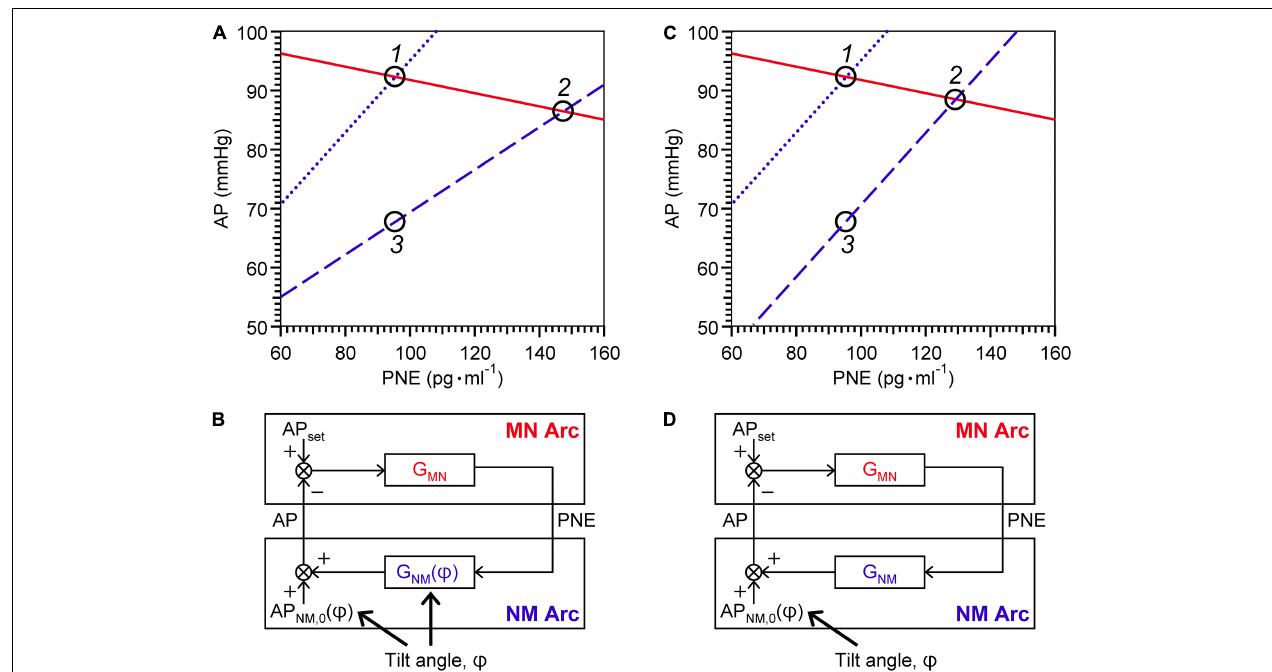
FIGURE 3 | Graphical representation of physiological meanings of gain factors of MN and NM arcs and a loop (A,C) against 15 ◦ head-up tilting (HUT), and block diagrams of sympathetic arterial baroreflex with (B) and without (D) a tilt-induced effect on the NM-arc gain. (A) The MN- (solid line), supine NM- (dotted line), and HUT NM- (dashed line) are reproduced with its average parameters summarized in Table 2 . For a line of the MN arc, AP = – 1/G MN PNE + AP MN , 0 ; for a line of the NM arc in supine position, AP = G NM (0) PNE + AP NM , 0 (0); and for a line of the NM arc in 15 ◦ HUT, AP = G NM (15) PNE + AP NM , 0 (15). (C) The MN- and supine NM-arc curves are identical with (A) while the HUT NM-arc curve is assumed to move down in parallel with the supine NM-arc curve. Using equilibrium diagrams (A,C) , we can graphically explain how sympathetic arterial baroreflex attenuates the effect of external disturbance on the circulatory system in humans. During baseline condition, the operating point moves from Point 1 to Point 2 along the functional curve of the MN arc in response to changes in tilt angle (A) . The difference in AP before and after 15 ◦ HUT is estimated to be 6 mmHg. However, if the MN arc does not respond to AP change at all, the operating point should move down vertically from Point 1 to Point 3 , and thus the AP difference before and after tilting is assumed to reach 24 mmHg. Consequently, the effect of 15 ◦ HUT on AP is considered to be attenuated to 1/4 by sympathetic arterial baroreflex. If this attenuation ratio is used for estimation of G L , it is calculated to be 3 according to the following formula: G L = 1/(attenuation ratio) – 1. However, the estimated value for G L is not consistent with G L (0). The reason for this inconsistency is that HUT affects G NM as well as AP NM , 0 . If G NM were independent of tilt angle, the NM-arc curve in 15 ◦ HUT position would become parallel to that in supine position (C ), and then the AP difference between Point 1 and Point 2 before and after tilting is assumed to be less than 4 mmHg during baseline condition. Therefore, the G L estimated from the attenuation ratio should exactly coincide with the G L (0). AP, arterial pressure; PNE, plasma norepinephrine level; AP set , set-point value for AP; AP NM , 0 , AP that is generated by the cardiovascular system at null PNE; G MN , gain for MN arc; G NM , gain for NM arc; ϕ , tilt angle. See text for detailed